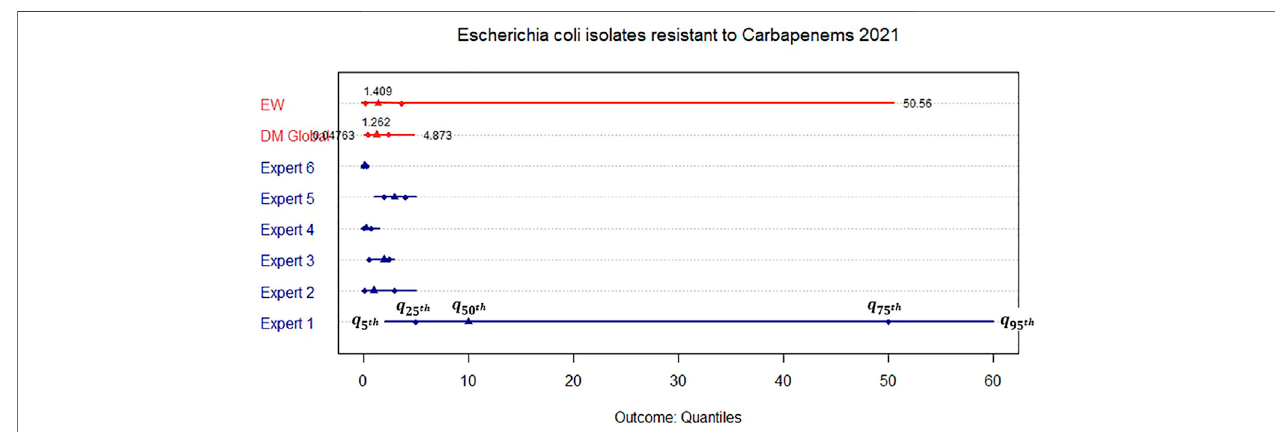
FIGURE2| Elicitedmarginaldistribution(5 th ,25 th ,50 th ,75 th ,and95 th quantile)fortherateofresistanceof Escherichiacoli isolatesresistanttoCarbapenemsinthe United Kingdom in